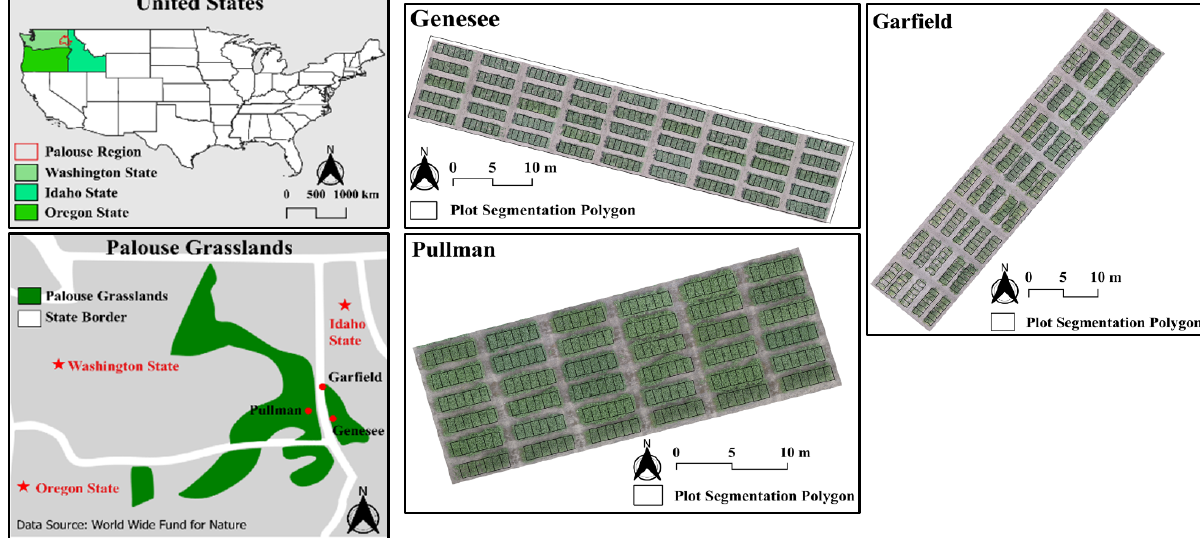
Figure 1. Region of the study area and locations of the three breeding trials in the Palouse region: Genesee, ID (2018–2019), Garfield, WA (2018–2019), and Pullman, WA (2019–2020), USA. Data